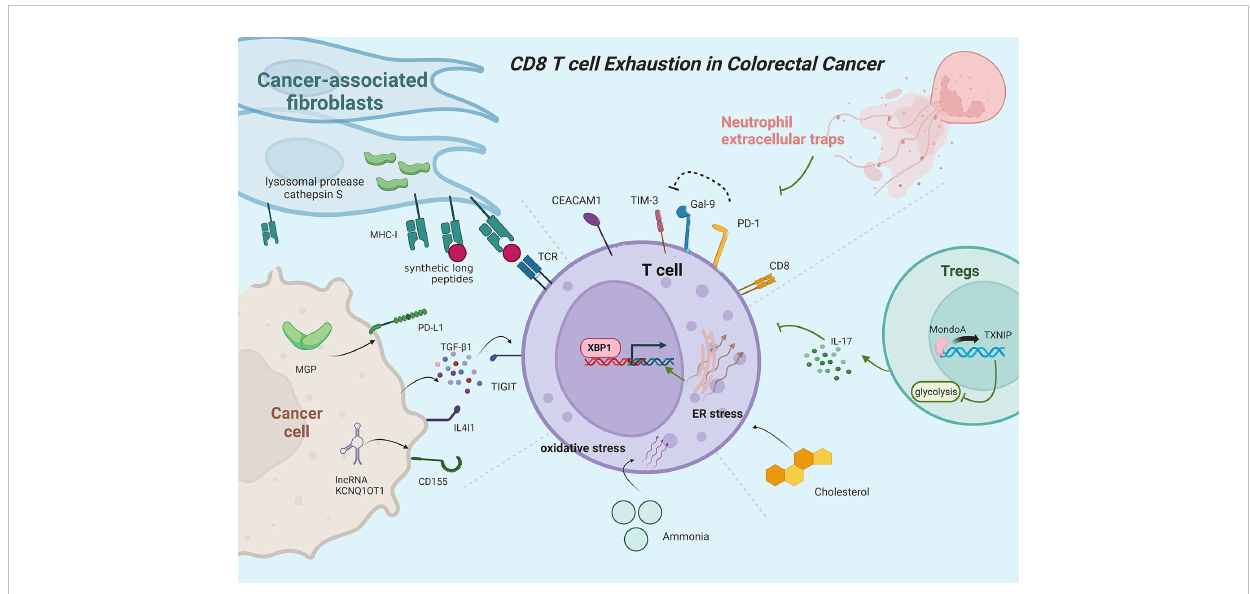
FIGURE 4 Mainly mechanisms of CD8 + T cell exhaustion in colorectal cancer. PD-1 protects exhausted T cells from Gal-9-induced cell death. CEACAM1 co- expresses with TIM-3 to promote T-cell exhaustion. Neutrophil extracellular traps can promote T cell exhaustion. Inhibition of the MondoA – TXNIP axis induces hyperglycolytic regulatory T cells to produce IL-17A and promotes T cell exhaustion. Cholesterol increases endoplasmic reticulum stress and activates XBP1 to induce transcription of immune checkpoints. Ammonia induces oxidative stress and T-cell exhaustion. MGP activates PD-L1 expression in cancer cells. Cancer cells can secrete TGF- b 1 to inhibit T cell function. CD155 expression positively correlates with lncRNA KCNQ1OT1. Cancer-associated fi broblasts upregulate lysosomal protease cathepsin S expression and boost the capacity to cross-present synthetic long peptides, promoting T cell